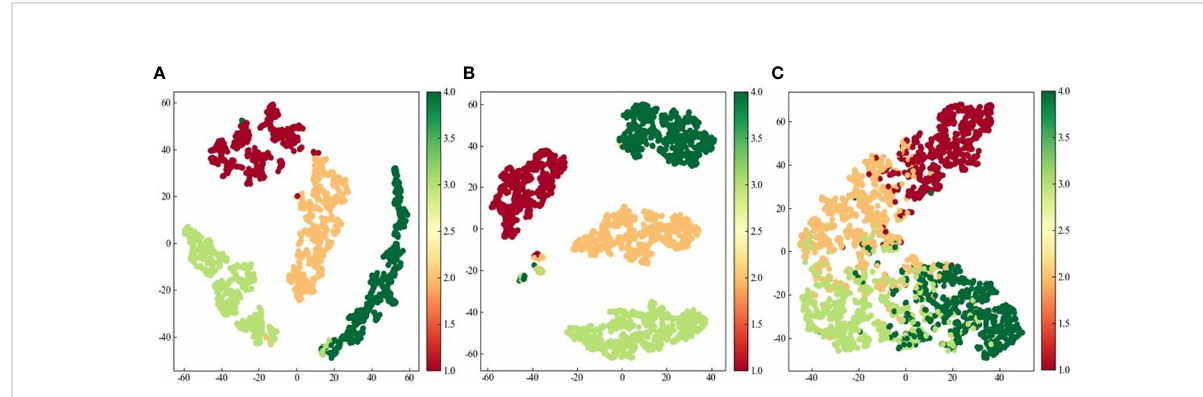
FIGURE 8 t-SNE based two-dimensional clustering analysis of different fi sh appetite grading methods (see Figure S1 in supplementary materials for more details). (A) GCN_Dataset 4. (B) RNN_Dataset 4. (C) CNN.